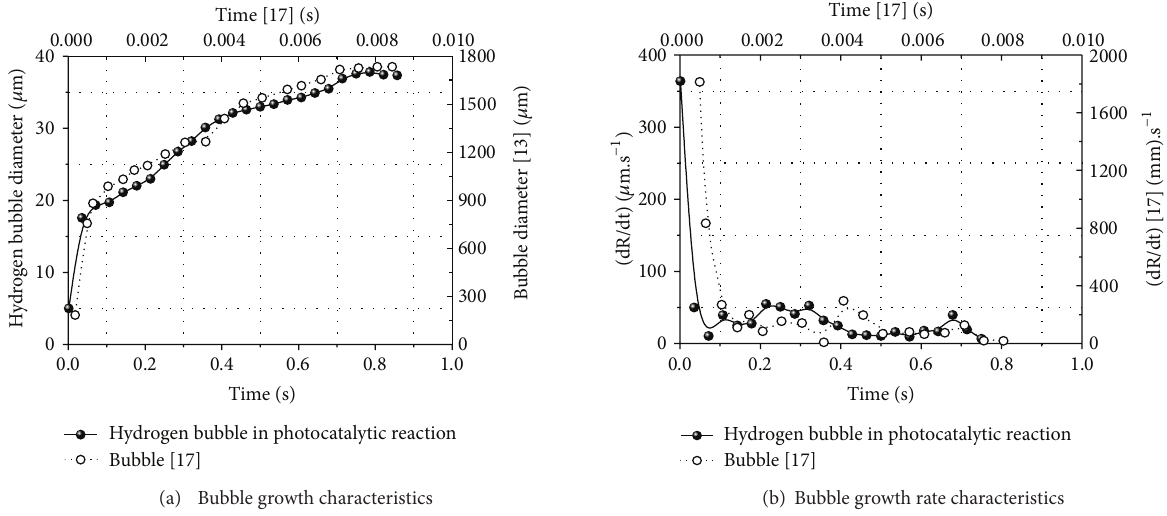
Figure 3: Hydrogen bubble growth characteristics during a bubble growth period and the comparison with the bubble growth under the condition of nucleate